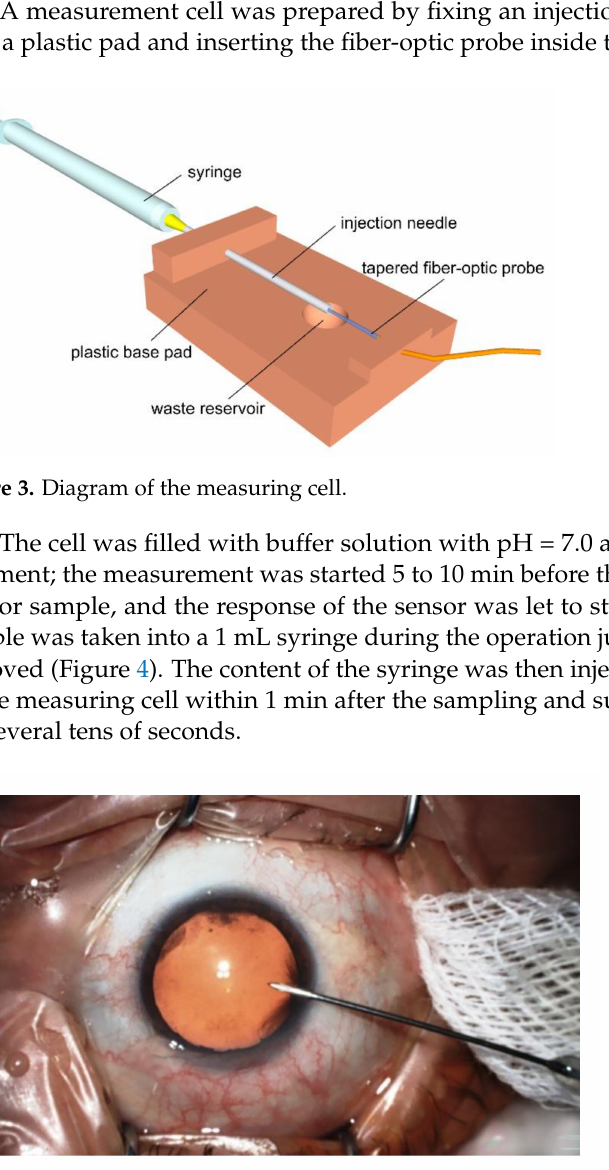
Figure 4. Retrieval of an aqueous humor sample during cataract